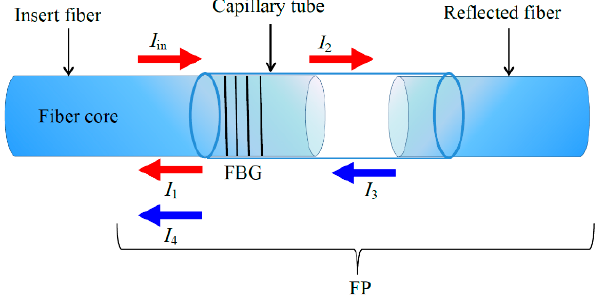
Figure 1. The structure of a FP-FBG sensor.